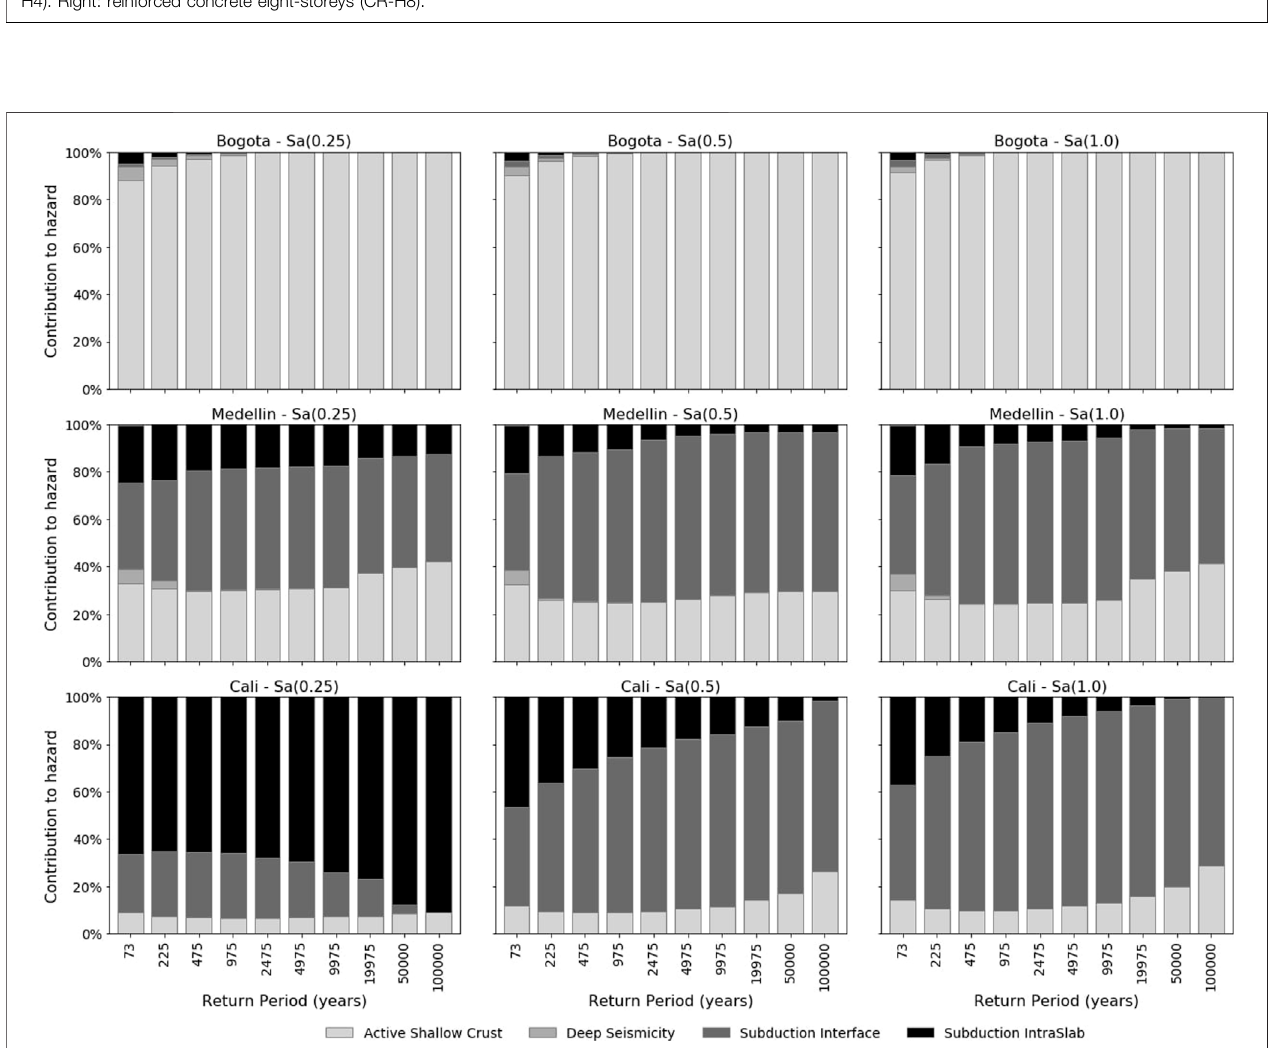
FIGURE 3 | Tectonic regime contribution in the three cities: Bogotá (top), Medellín (center), and Cali (bottom) for the three-building types: two-story unreinforced masonry (left), four-story reinforced concrete (center), and eight-story reinforced concrete (right), for different return periods.